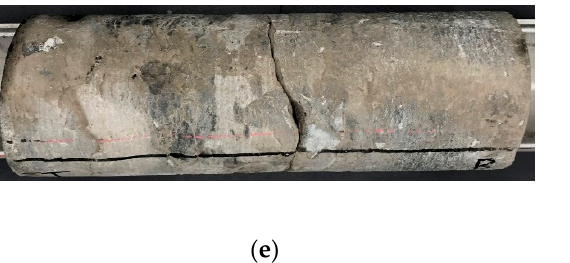
Figure 8. ( a ) The NMR measurements of core A with and without quality control. ( b ) Inverted fluid contents for core A using p = 1.0, 1.1, 1.2, 1.3, 1.7, and 2.0. ( c ) The NMR measurements of core D with and without quality control. ( d ) Inverted fluid content for core D using p = 1.0, 1.1, 1.2, 1.3, 1.7, and 2.0. ( e ) Photo of core D.